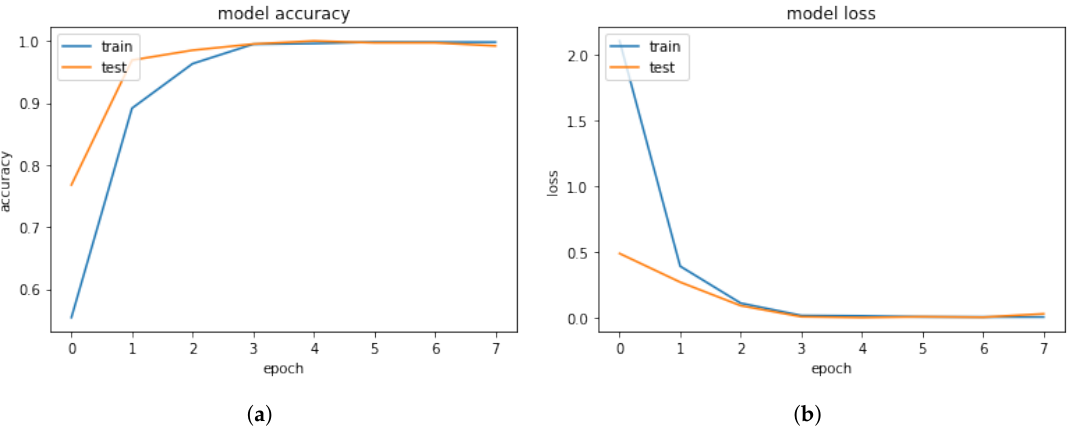
Figure 10. DL Training and Testing Results. ( a ) DL Model Training Accuracy. ( b ) DL Model Training Loss.